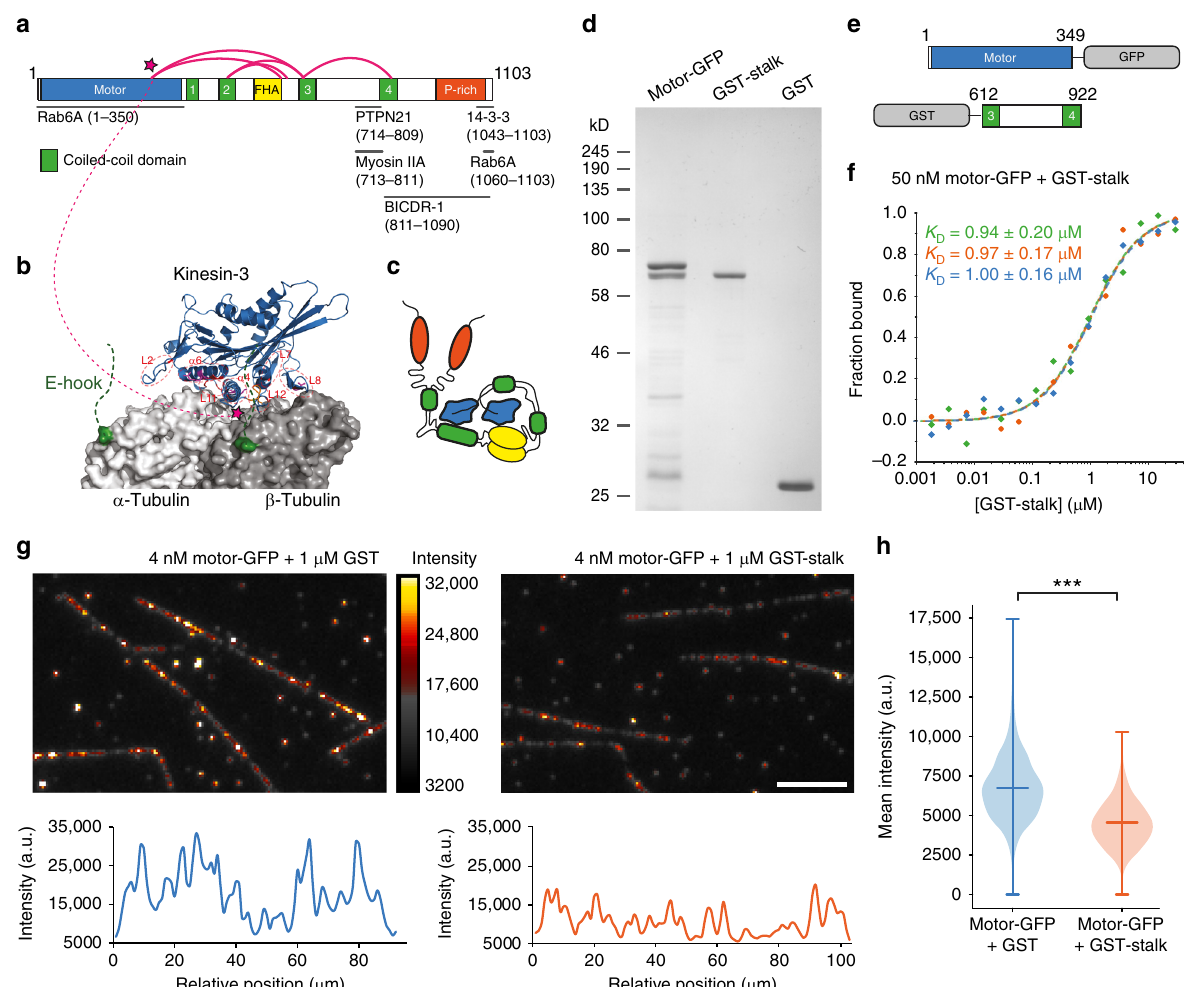
Fig. 2 KIF1C is autoinhibited by intramolecular interactions of stalk and motor domain. a Schematic primary structure of KIF1C with motor domain (blue), coiled-coil domains (green), FHA domain (yellow), and Proline-rich domain (orange). Crosslinks identi fi ed using mass spectrometry after treatment with BS3 or EDC are shown as magenta loops. Published binding sites for KIF1C interactors are indicated below. See Figs. S2 and S3 for ion fragmentation of crosslinked peptides. b Motor domain of related KIF1A on tubulin. The region in the motor domain that interacts with KIF1C stalk is indicated by magenta stars. c Hypothetical model of autoinhibited KIF1C conformation based on identi fi ed crosslinks. d Coomassie-stained SDS-PAGE gel of puri fi ed KIF1C motor domain, stalk domain and GST control. e Schematic primary structure of KIF1C motor and stalk proteins used here. f Binding af fi nity measurements and Kd model fi ts from three microscale thermophoresis experiments probing the interaction of KIF1C motor domain with the stalk domain. g Representative TIRF images showing microtubule decoration of KIF1C motor domain in the presence of GST (control) and KIF1C tail domain. Scale bar 5 µ m. Linescans of one of the microtubules from each fi eld is shown below. h Quanti fi cation of mean intensity of KIF1C motor domain on microtubules. Distribution is shown together with mean and full extent of data. n = 690 and 659 microtubules, respectively, pooled from six experiments. *** indicates p = 10 − 99 ( t